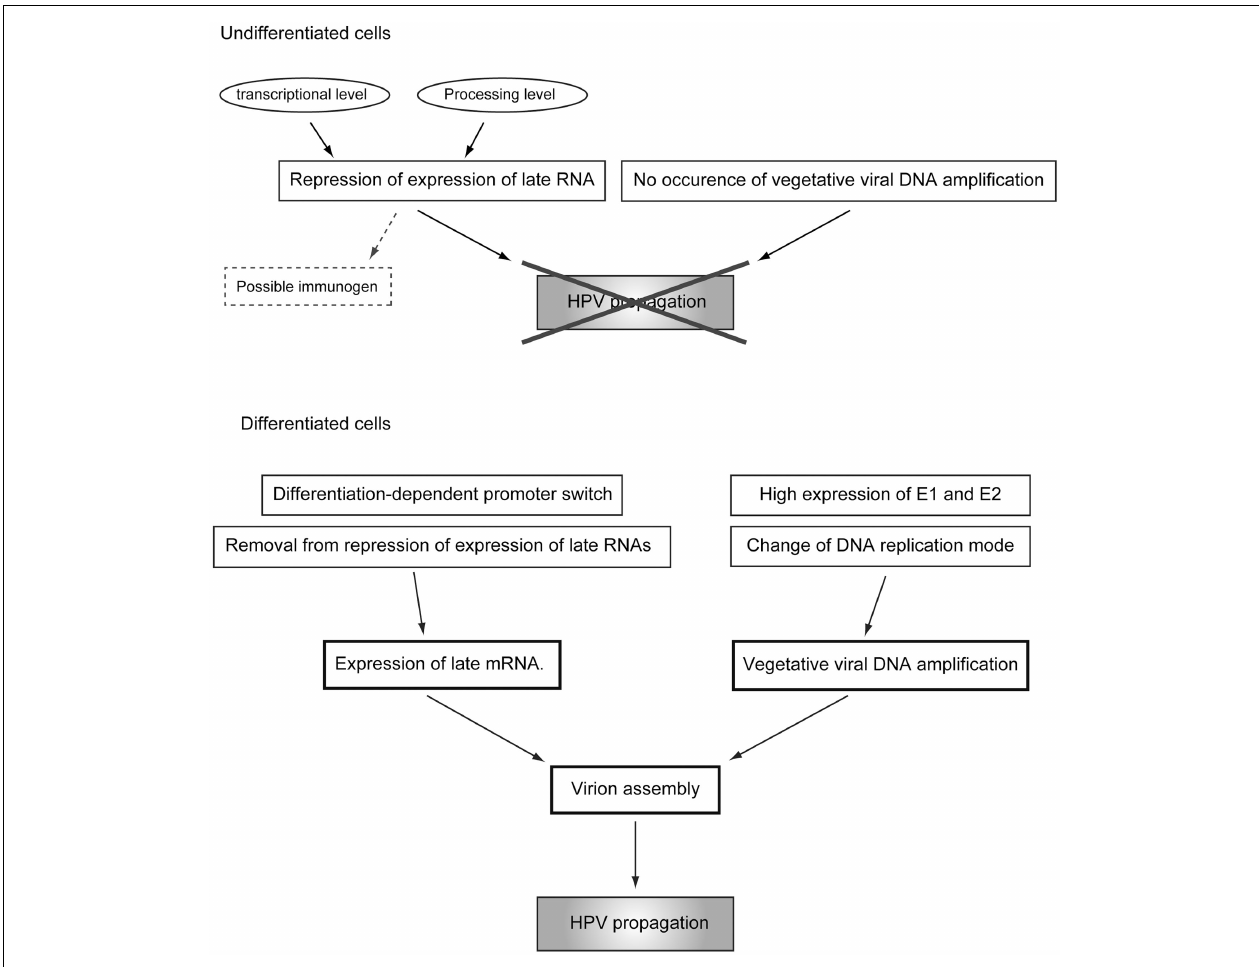
FIGURE 6 | Regulatory mechanisms of the differentiation-dependent lifecycle of